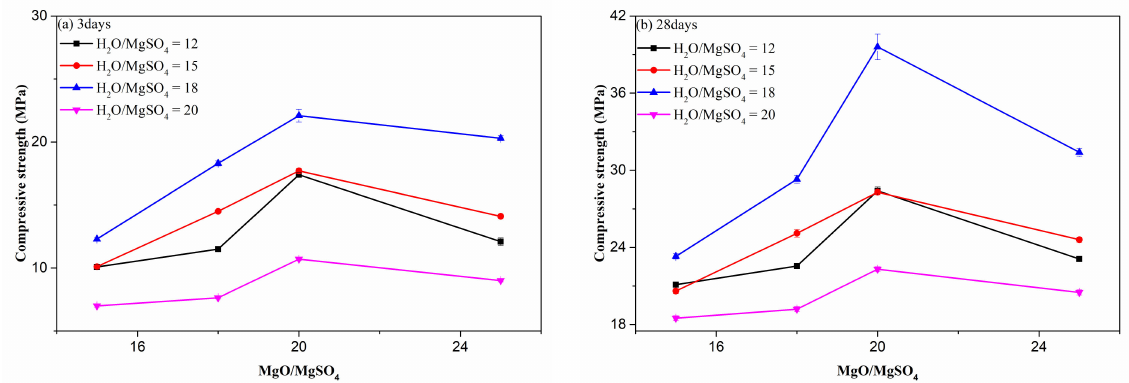
Figure 3. Effect of M/S on the compressive strength of cement paste.